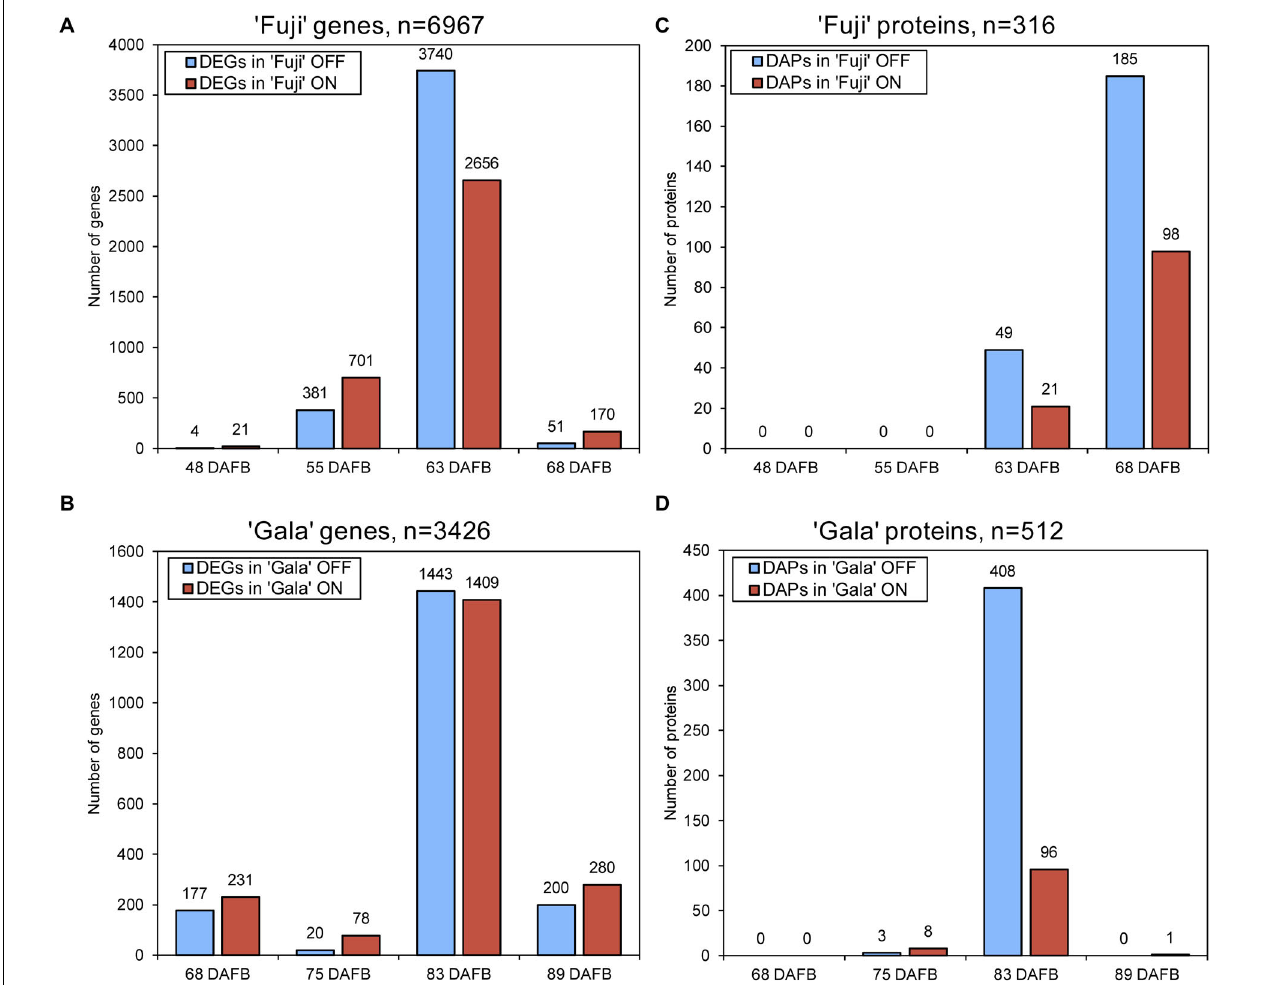
FIGURE 2 | The number of differently expressed genes (DEGs) (A,B) and differentially abundant proteins (DAPs) (C,D) in ‘Fuji’ (A,C) and ‘Gala’ (B,D) between ON- and OFF-trees over 4 weeks prior to flower initiation. Flower initiation in ‘Fuji’ occurred 75 DAFB and that in ‘Gala’ 97 DAFB. The sums of the bar plots are not equal to the numbers ( n ) shown above each plot as n indicates the total number of unique DEGs and